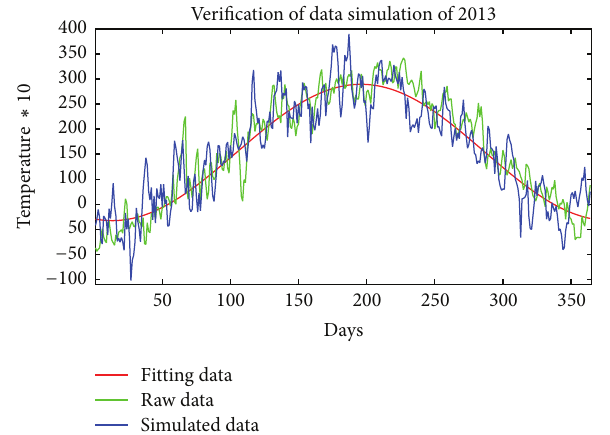
Figure 6: Comparison of simulation results and actual values at Zhengzhou (2013).